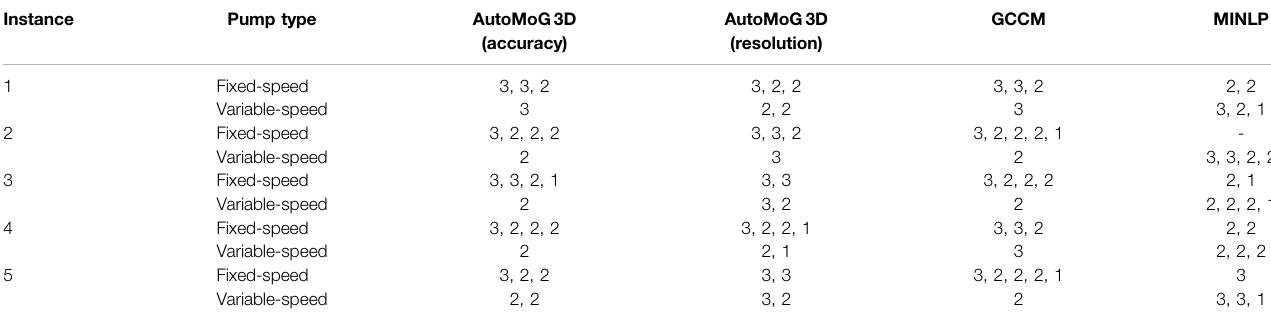
TABLE 1 | Design of the pump system for all instances and models. The table lists the nominal volumetric fl ow rate of each installed pump. The nominal volumetric fl ow rate _ V nom of each installed pump is presented in 1,000 m 3 h − 1 .